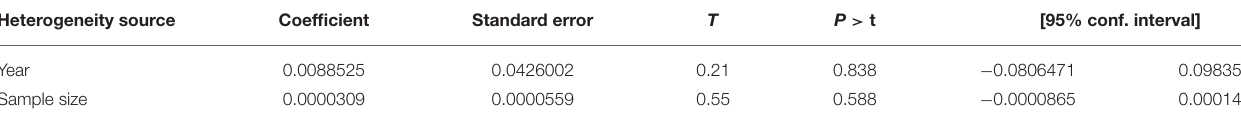
TABLE 2 | Meta regression analysis of factors affecting between study heterogeneity. Heterogeneity